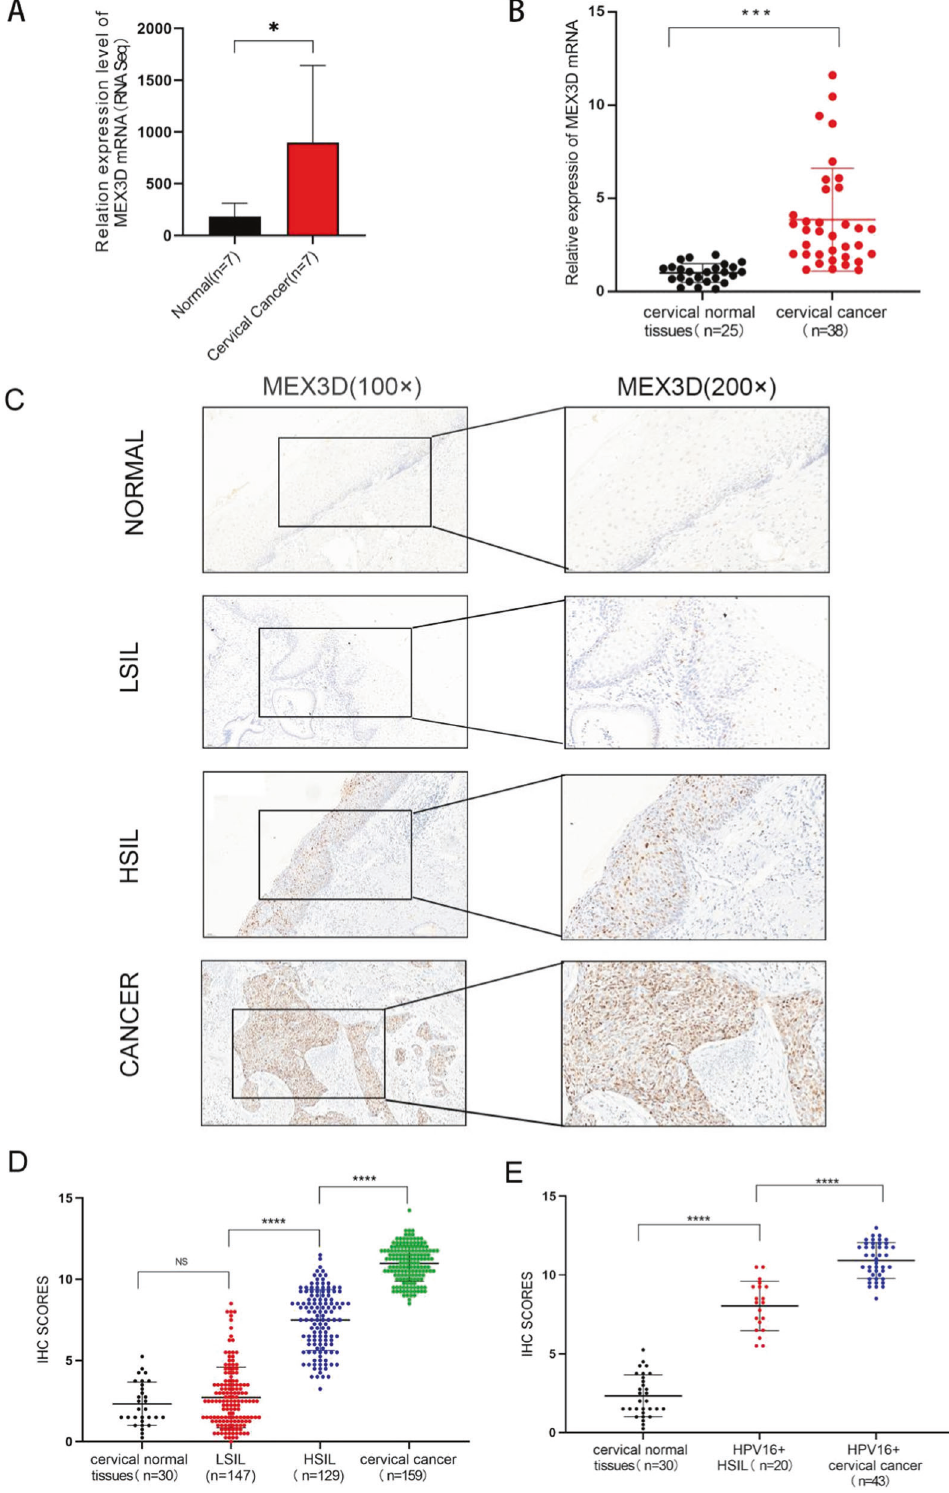
Fig. 1 MEX3D expression is elevated in cervical cancer tissues. A RT-qPCR validation of MEX3D mRNA in seven cervical cancer tissues and seven normal cervical tissues. B MEX3D mRNA expression levels in 25 cervical normal epithelium samples and 38 cervical cancer tissue samples. C Representative IHC images of MEX3D expression of the normal cervix, LSIL, HSIL, and cervical cancer tissues. D IHC scores analyses of MEX3D protein expression in normal cervix ( n = 30), LSIL ( n = 147), HSIL ( n = 129), and cervical cancer tissues ( n = 159). E IHC scores analyses of MEX3D protein expression in HPV16-negtive normal cervix ( n = 30), HPV16-positive HSIL ( n = 20), and HPV16-positive cervical cancer ( n = 43). NS not signi fi cant; * P < 0.05, *** P < 0.001, **** P < 0.0001.